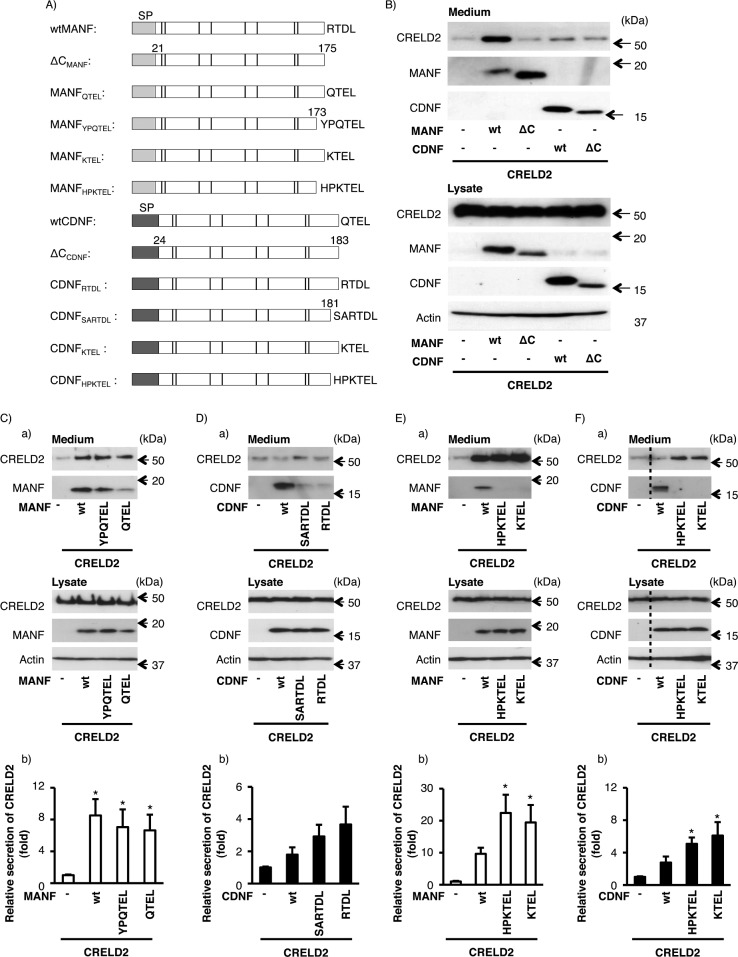
Effects of mouse MANF and CDNF co-expression on the CRELD2 secretion from HEK293 cells.(A) Schematic representation of the mouse MANF and CDNF expression constructs used in this study. SP indicates a signal peptide at the N-terminus of each protein. The cysteines are indicated by bars. The four or six C-terminal amino acids, RTDL, SARTDL, QTEL, YPQTEL, KTEL and HPKTEL, in each construct are shown in capital letter. After co-expression of wtCRELD2 with (B) wtMANF, ΔCMANF, wtCDNF or ΔCCDNF, (C) wtMANF, MANFYPQTEL or MANFQTEL, (D) wtCDNF, CDNFSARTDL or CDNFRTDL, (E) wtMANF, MANFHPKTEL or MANFKTEL, (F) wtCDNF, CDNFHPKTEL or CDNFKTEL, the indicated proteins were detected by western blot analysis as described in Fig 2. Representative data of three independent cultures were shown (B, C-a, D-a, E-a, F-a). The broken line represented the boundary line between the two lanes in the same immunoblotted membrane. (C-F b) Each of bar graphs shows densitometric analyses of the secreted CRELD2 as described in the Materials and Methods. Each value represents the mean ± SEM from 8 (C), 10 (D), 6 (E), 6 (F)-independent cultures. The values marked with an asterisk are significantly different from the values of the mock-transfected cells (p<0.05).